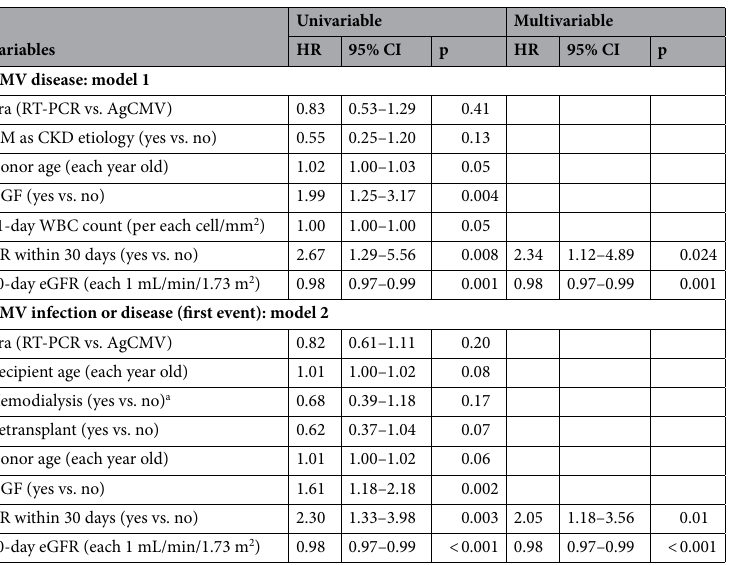
Table 3. Univariable and multivariable analyses for CMV-disease and first CMV-associated event. Variables included in the model 1: era (antigenemia or RT-PCR), diabetes as CKD etiology, donor age, DGF, 21-day WBC count, 30-day eGFR and AR within 30 days after transplantation. KDPI was excluded due to collinearity with donor age. The model’s AUC-ROC to predict CMV disease: 0.743 (95% IC 0.681–0.806). Variables included in the model 2: era (antigenemia or RT-PCR), recipient age, hemodialysis as replacement renal therapy before the transplantation, retransplant, donor age, DGF, 30-day eGFR and AR within 30 days after transplantation. Cold ischemia time was excluded due to collinearity with DGF. The accuracy of the multivariable modeling for predicting CMV-related event was assessed by an AUC-ROC, which achieved a result of 0.792 (95% CI 0.745–0.839). AR, acute rejection; CKD, chronic kidney disease; DGF, delayed graft function; eGFR, estimated glomerular filtration rate; WBC, white blood cells. a Hemodialysis as the renal replacement therapy before